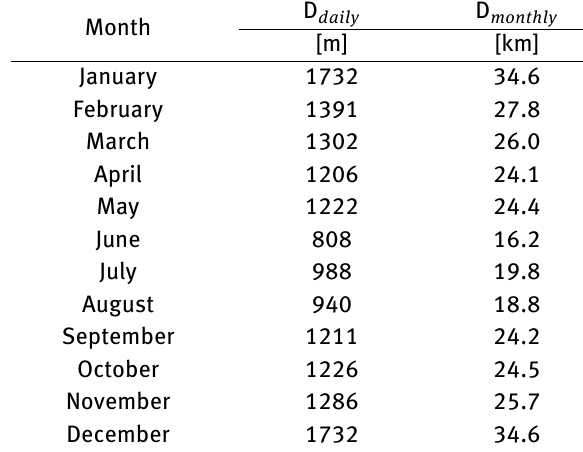
Table 5: Average monthly ambient temperature at 7:30 a.m. and 4 p.m. and engine running time on gasoline.